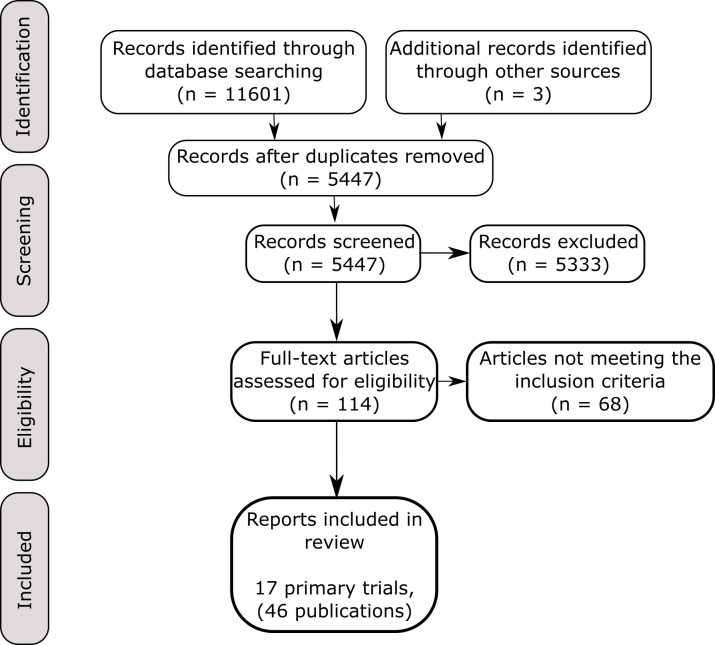
PRISMA flow diagram.